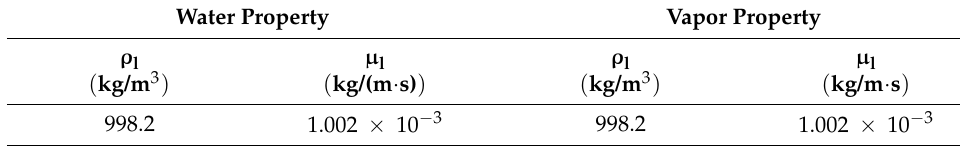
Table 4. Fluid properties.